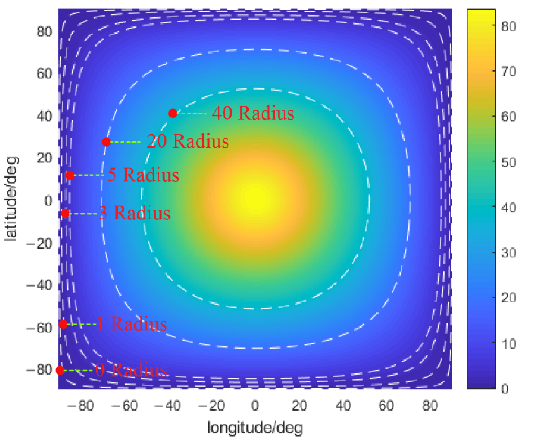
Figure 3. The approximate dividing lines correspond to different TAs for average Earth centroid’s elevation distribution in the period of 18.6 years.